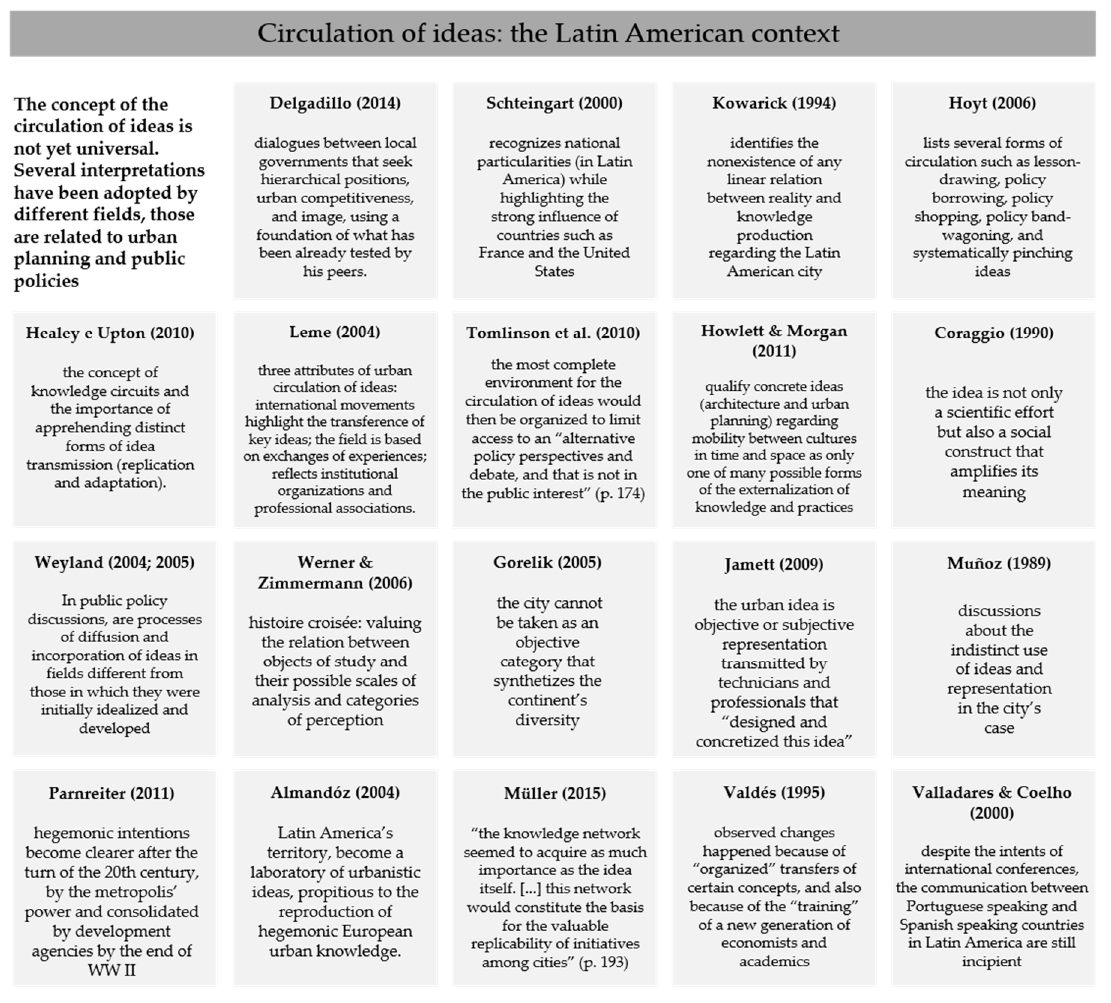
Figure 1. The construction of the circulation of ideas concept in the Latin American context.